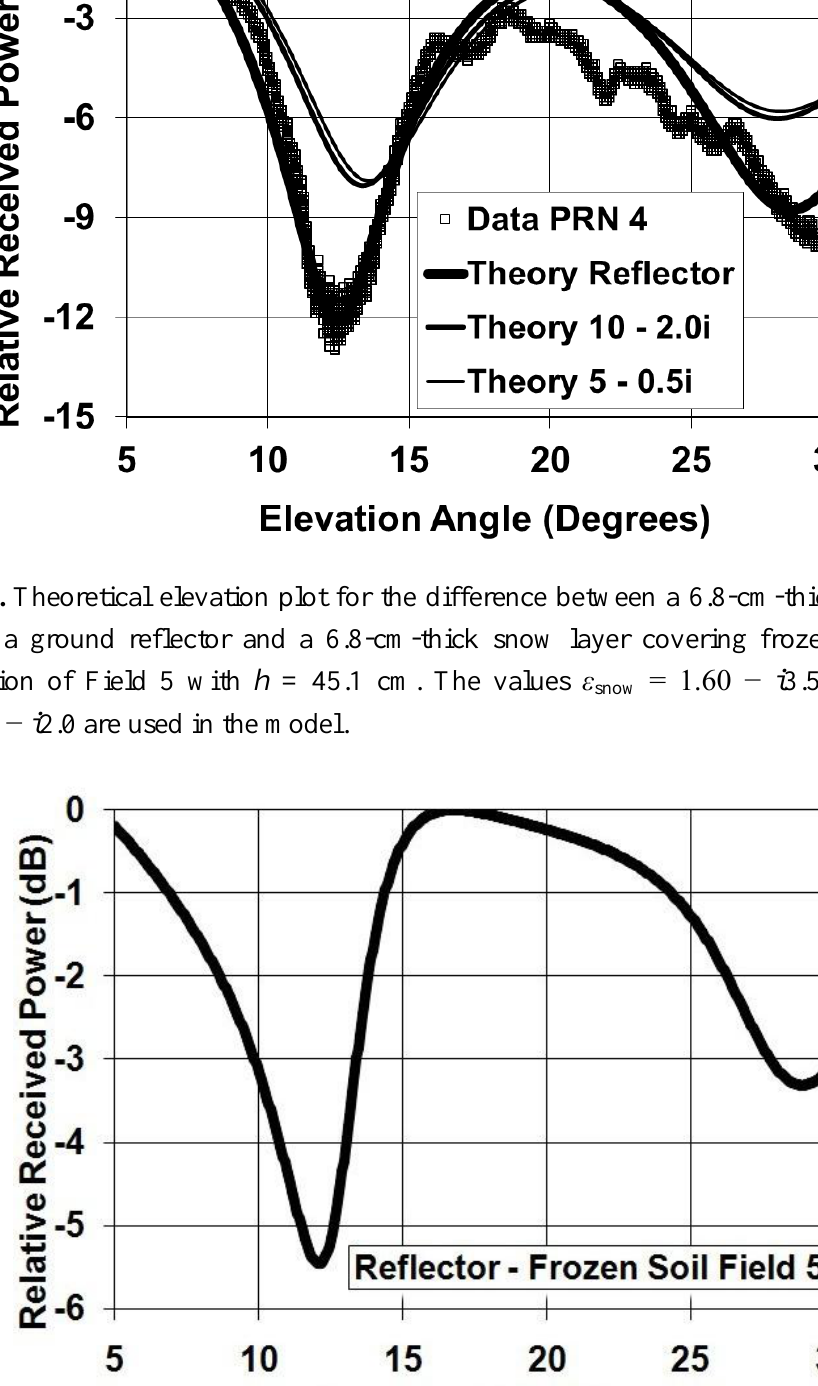
Figure 5. (Lines) Theoretical and (square) measured elevation plots for a 6.8-cm-thick snow layer covering a ground reflector and two types of frozen soil with h = 45.1 cm for the GPS satellite PRN 4. The soil characteristics are given in Table 3. The values ε = 1.60 − i 3.58 × 10 −4 , ε = 5 − i 0.5 and ε = 10 − i 2.0 are used in the model. The snow soil1 soil5 GPS times from the measurements are 14:44 to 15:52.